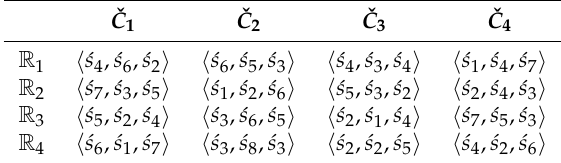
Table 2. R 2 (Decision-matrix).